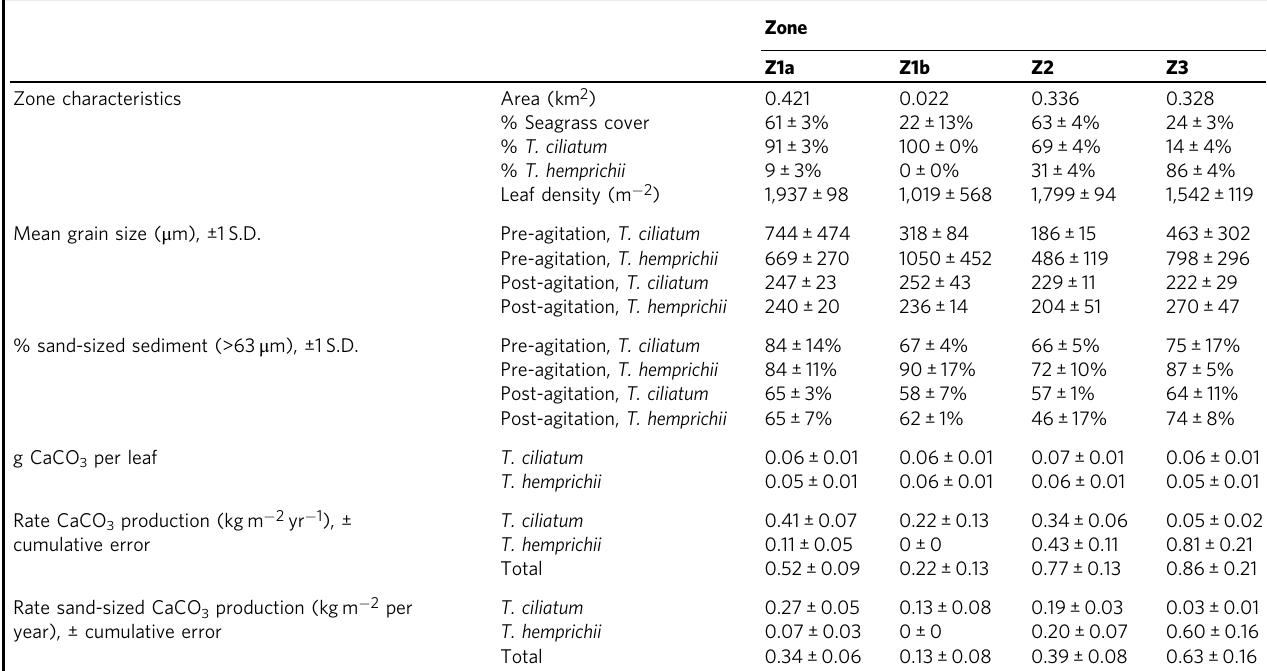
Table 1 Summary of seagrass zone characteristics, species-level grain size data, mass of sediment per leaf and epibiotic sediment production